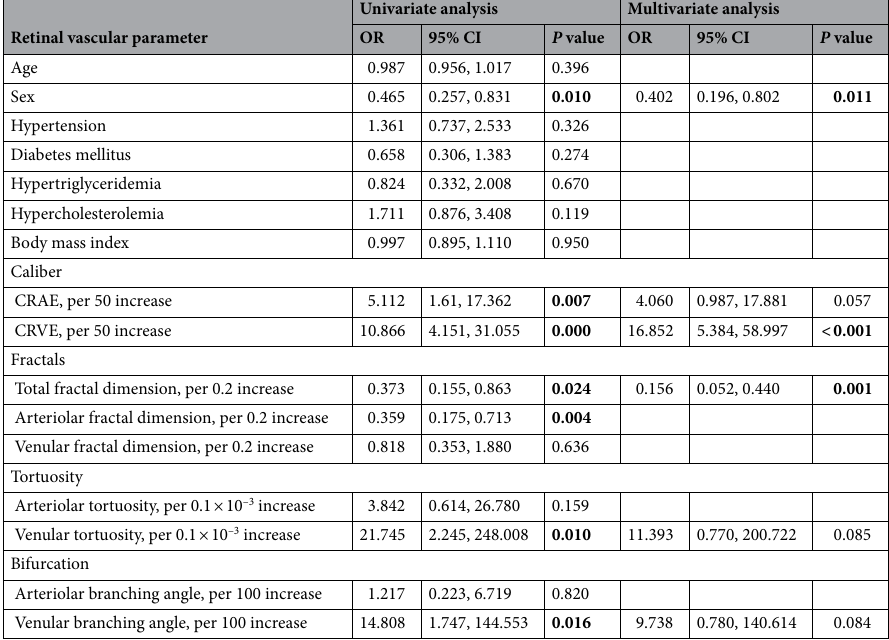
Table 3. Associations between idiopathic epiretinal membrane and retinal vascular parameters. Significant values are in bold. CRAE central retinal arteriolar equivalent, CRVE central retinal venular equivalent, OR odds ratio, CI confidence interval.